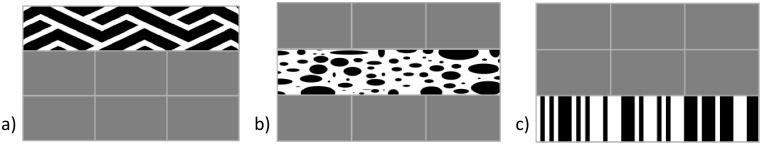
a, b and c. Images of the three touchscreen buttons, as they appeared during training phases.When pressed, each initiated the following actions: (a) turned on classical music for three seconds, (b) turned music off /silence on for three seconds and (c) turned on pop/rock music for three seconds.